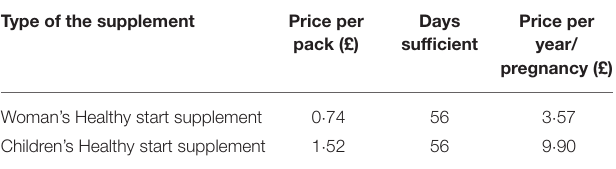
TABLE 3 | Prices of the vitamin D supplements (source: “Healthy Start”,